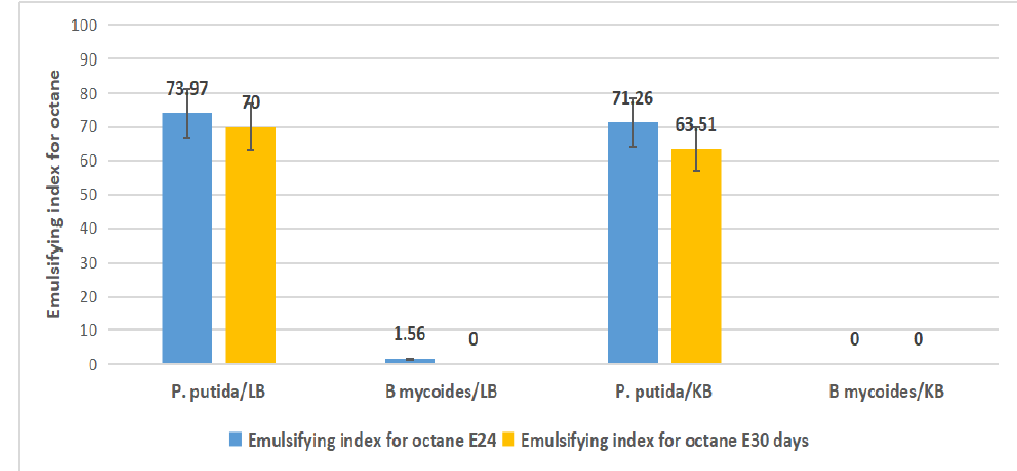
Figure 13. Emulsifying index for heptane (YMPG and M44).